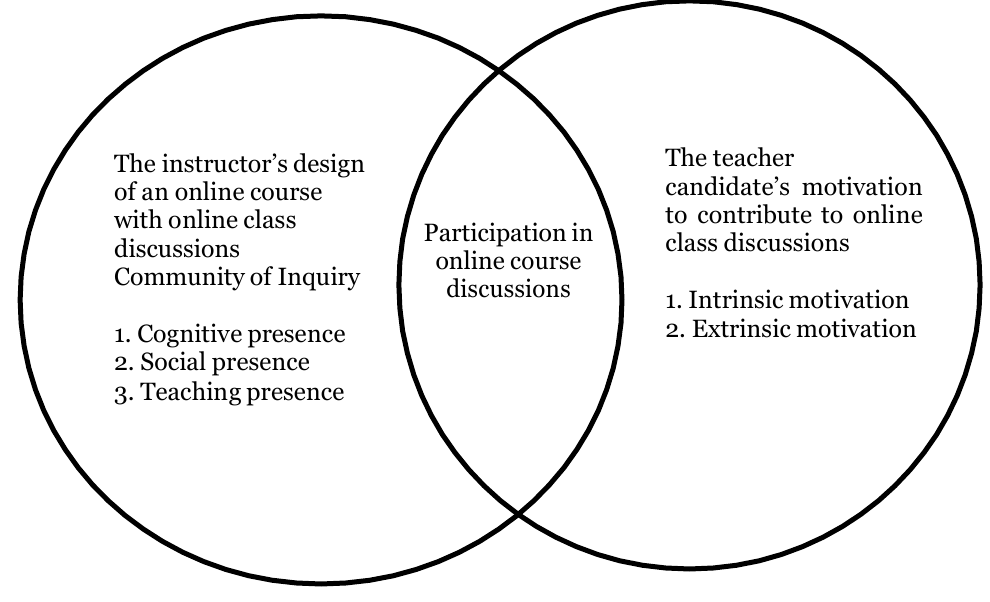
Figure 1. The interrelationship between the conceptual